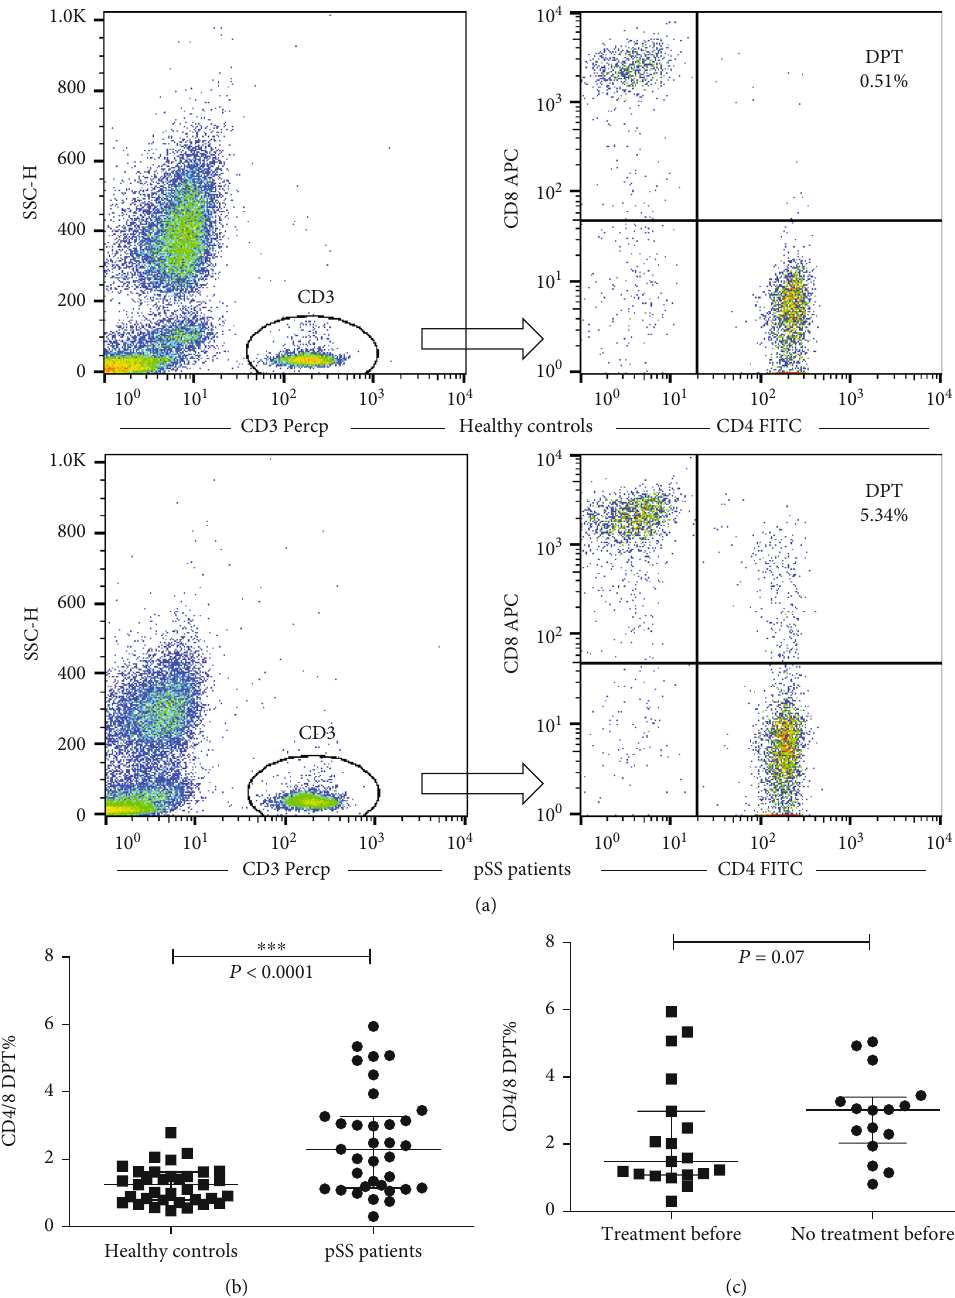
Figure 1: The frequency of peripheral DPT cells was increased in patients with pSS. (a) CD3 + cells were gated, and representative data of DPT were shown for healthy controls (upper panel) and pSS patients (lower panel). (b) Summary data of the frequency of peripheral DPT cells were shown for healthy controls in comparison with pSS patients. (c) Summary data for frequency of peripheral DPT cells were shown for patients receiving or not receiving immunosuppressive treatment before admission. Each dot represents one individual donor. The Mann- Whitney U test was used for comparison between the two groups. The error bars represent the median with interquartile